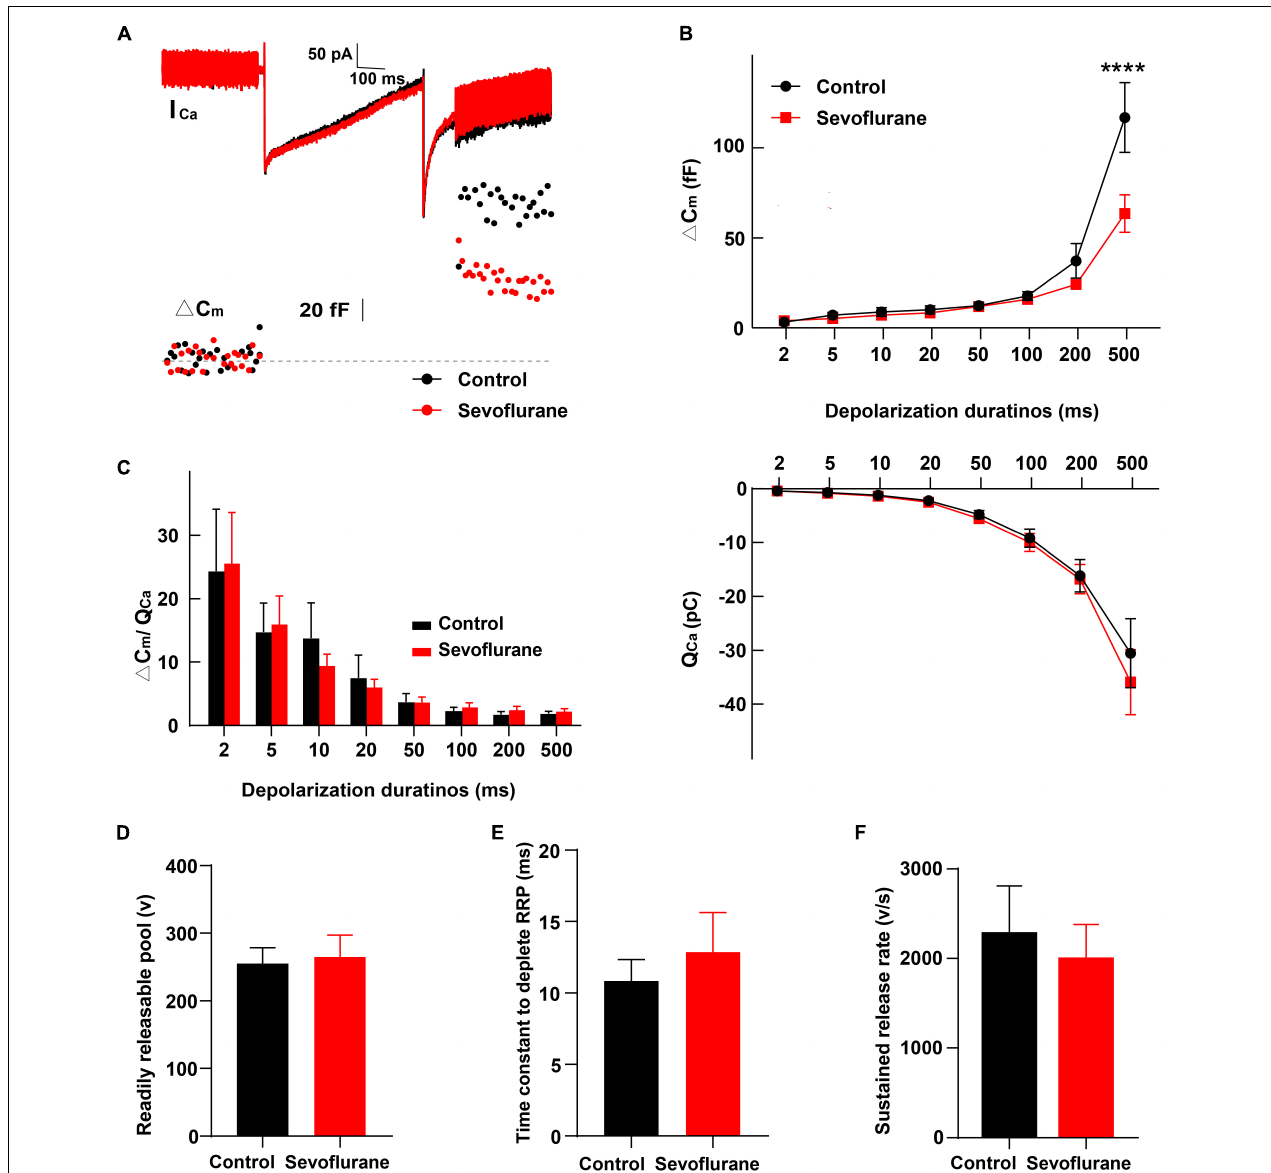
FIGURE 7 | Changes in inner hair cell (IHC) exocytosis following sevoflurane exposure. (A) Typical Ca 2 + currents (I Ca ) and capacitance jumps ( (cid:49) C m ) recorded from IHCs in the control group (black) and sevoflurane group (red). (B) (cid:49) C m and the Ca 2 + charge (Q Ca ) evoked by stimulations from 2 to 500 ms. Only for stimulations at 500 ms, (cid:49) Cm is significantly reduced following sevoflurane exposure. Q Ca is comparable between the two groups. (C) No difference is observed in the (cid:49) C m /Q Ca ratio, a surrogate for the efficacy of Ca 2 + to trigger exocytosis. (D) The readily releasable pool (RRP), (E) time constant to deplete RRP, and (F) sustained-release rate are similar between the two groups ( n = 8–17 control group, n = 10–24 sevoflurane group). **** P < 0.0001, two-way ANOVA in panels (B,C) , unpaired Student’s t -test in panels (D–F)